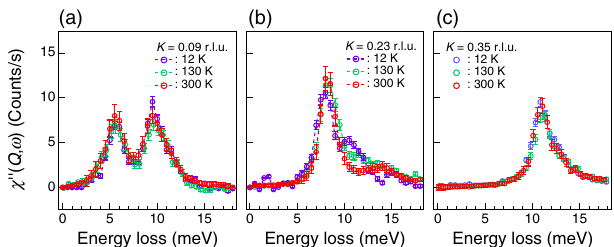
FIG. 2. Temperature dependence of the La 1 phonon spectra. (a) – (c) Elastic-line-subtracted and Bose-factor- corrected IXS spectra at K ¼ 0 . 09 , 0.23, and 0.35 r.l.u., respec- tively. Purple, green, and red circles correspond to data at 12, 130, and 300 K, respectively. Strong temperature dependence is seen at 0.23 r.l.u., whereas the K ¼ 0 . 09 and 0.35 r.l.u. show no obvious temperature